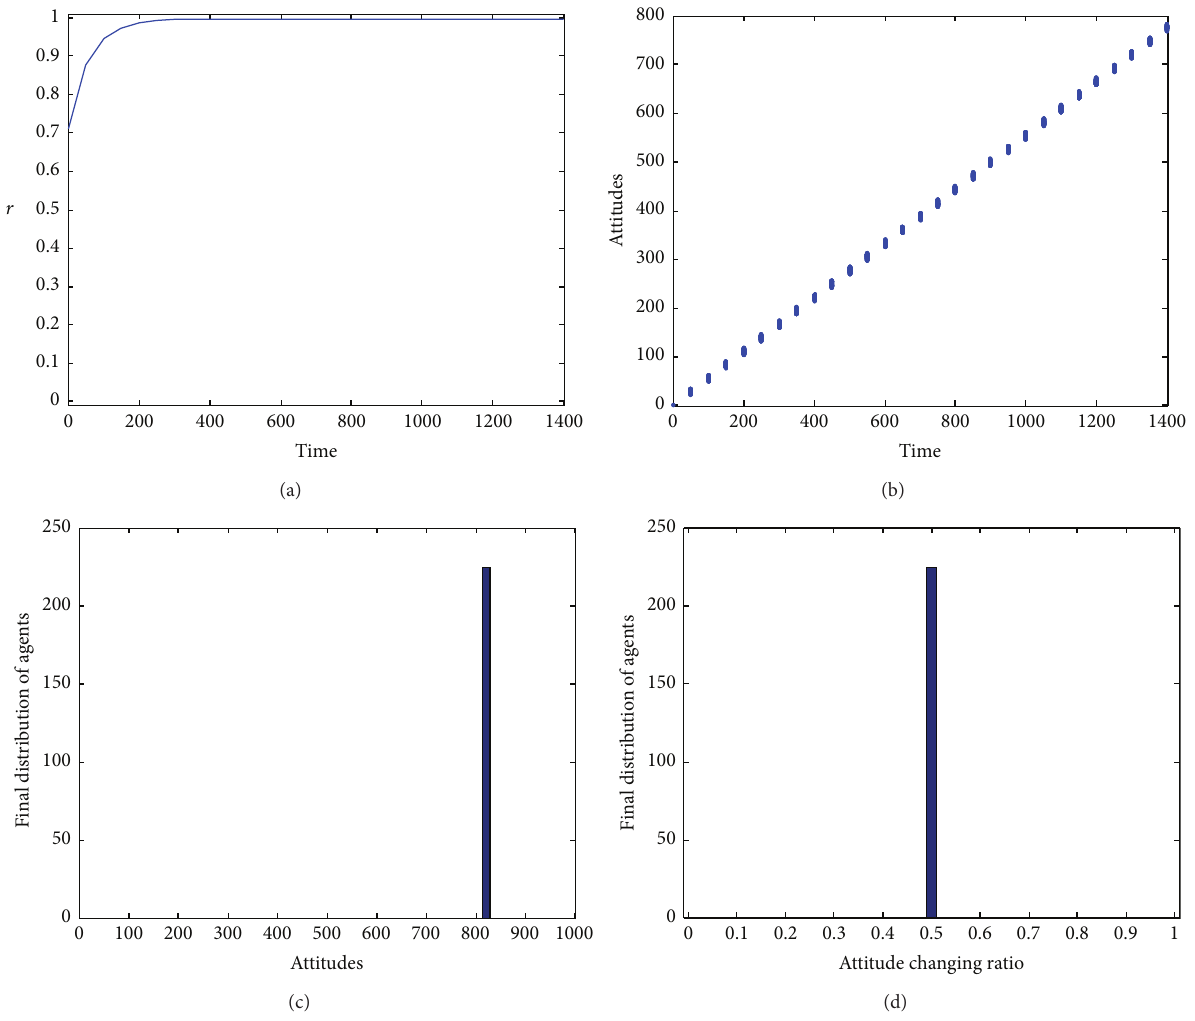
Figure 5: Results of simulation system with 𝐾 = 5 . (a) is the subfigure which shows synchronization criterion 𝑟 changes with time; (b) is the subfigure which shows group attitudes 𝑥(𝑡) versus time; (c) is the histogram of the final distribution of agents versus group attitudes 𝑥(𝑡) ; (d) is the histogram of the final distribution of agents versus attitude changing ratio ̇𝑥 𝑖 (𝑡)